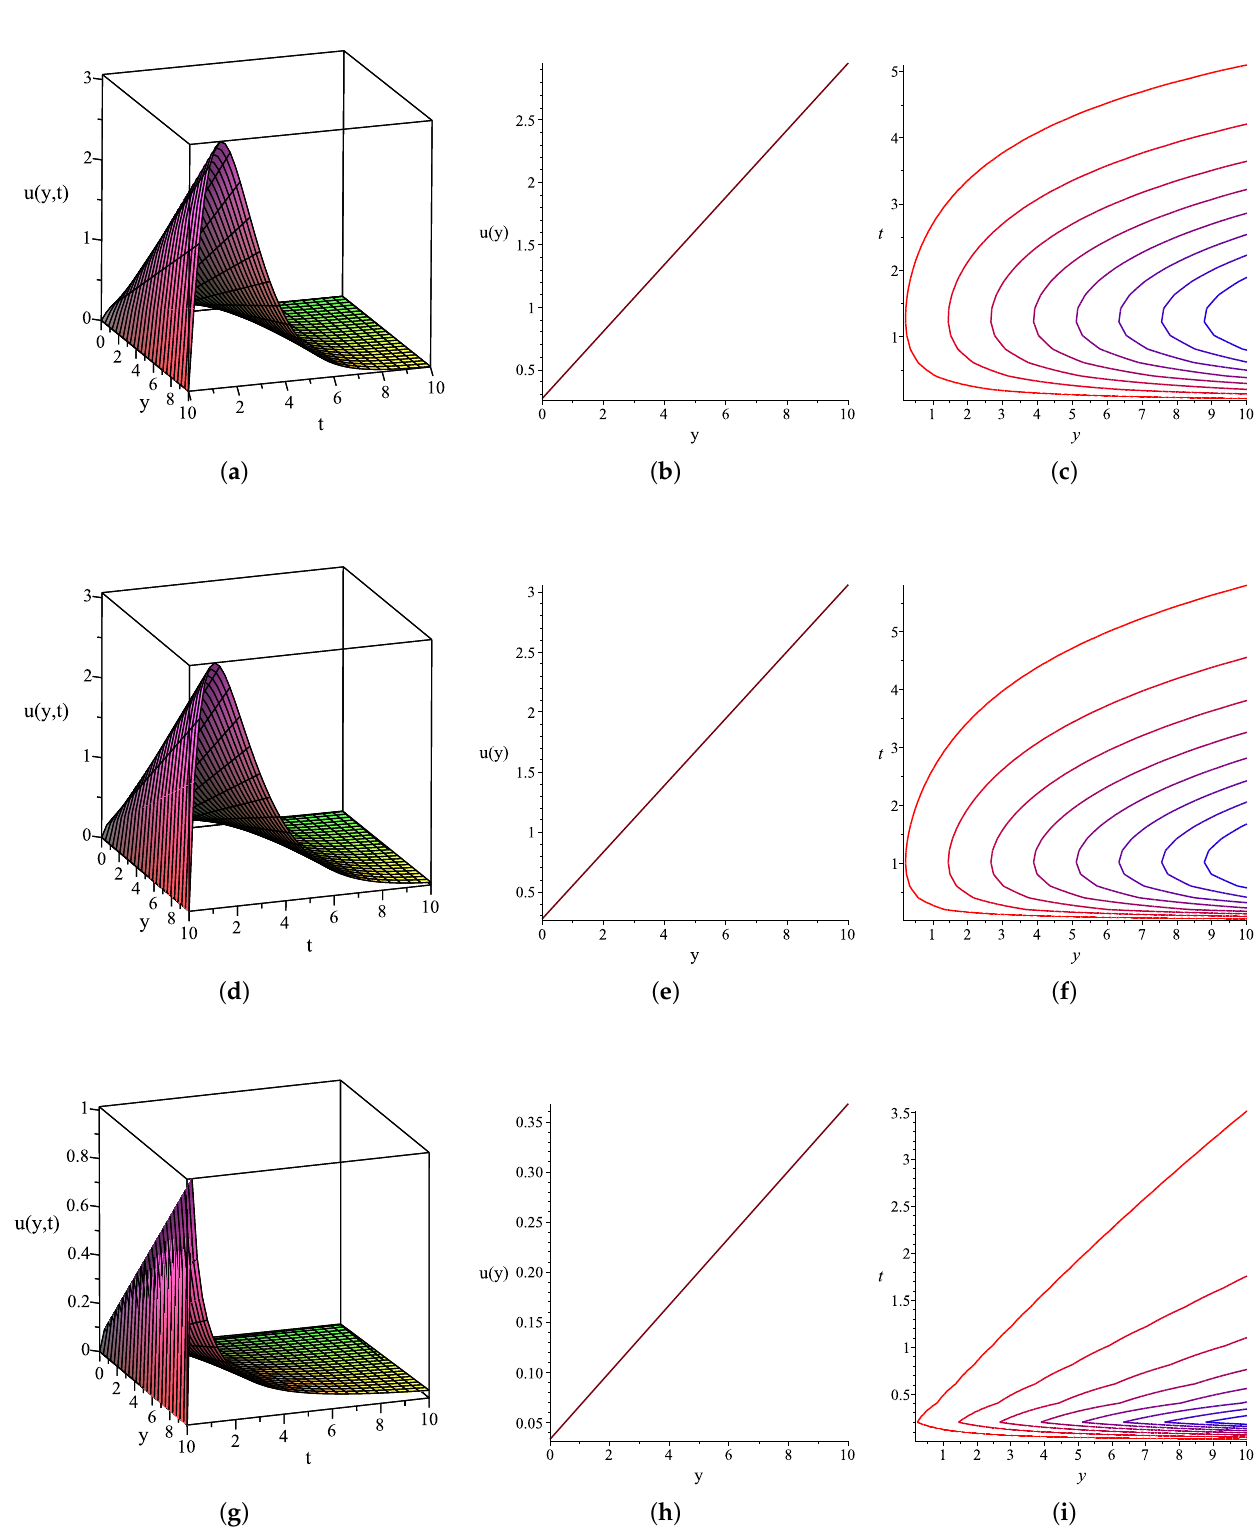
Figure 1. Associated plots of u 2 ( x , y , t ) in Equation (30) obtained using the auxiliary equation method: ( a – c ) 3-D plot, 2-D plot and contour plot, respectively when α = 1; ( d – f ) 3-D plot, 2-D plot and contour plot, respectively when α = 0.8; ( g – i ) 3-D plot, 2-D plot and contour plot, respectively when α =